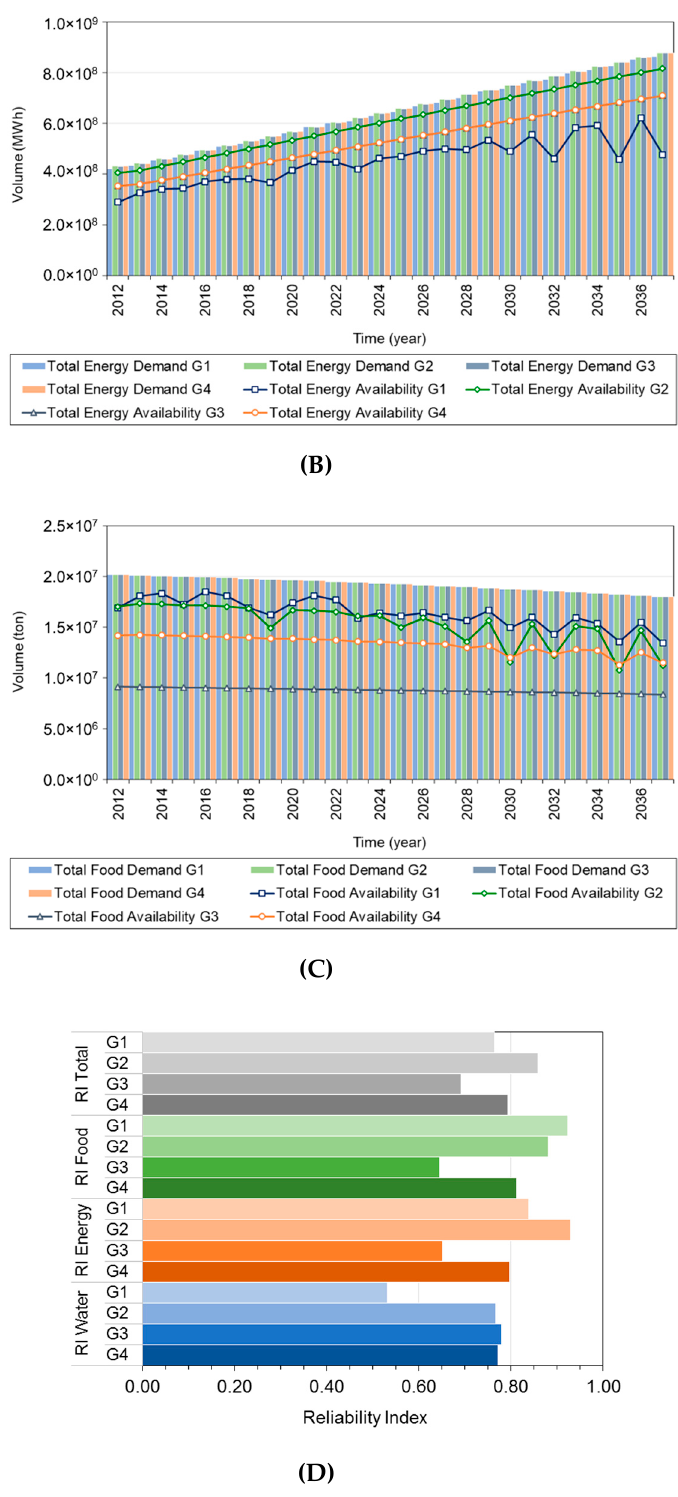
Figure 8. Representative solutions of the four groups showing results of ( A ) water, ( B ) energy, ( C ) food demand and supply, and ( D ) URIs. demand and supply, and ( D )